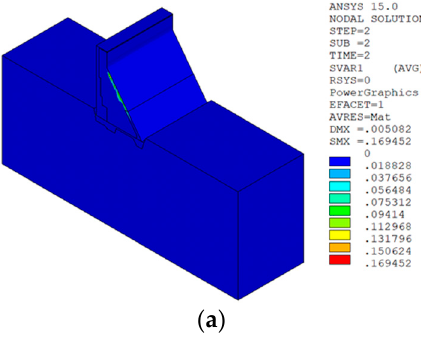
Figure 25. The temperature damage distribution of the dam is calculated by the macro model under the temperature rise condition, ( a ) Nephogram of temperature damage distribution of the dam, ( b ) Nephogram of temperature damage distribution of section z = 21 m. The three principal strain cloud charts on the section z = 21 m along the dam axis are shown in Figure 26.